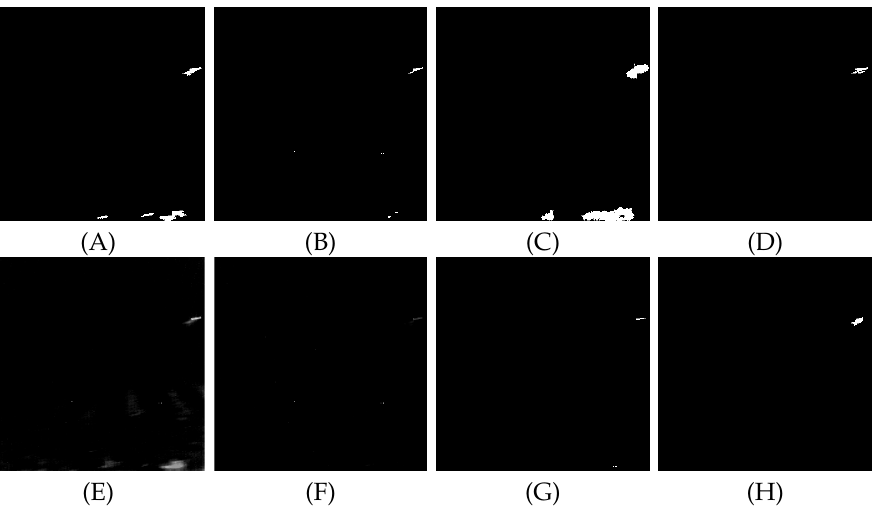
Figure A11. ( A – H ) shows the detection results of eight algorithms PSTNN, TV-PCP, VNTFR, anisotropy, ASTTV, SRWS, RPCA and propose method, respectively, under sequence